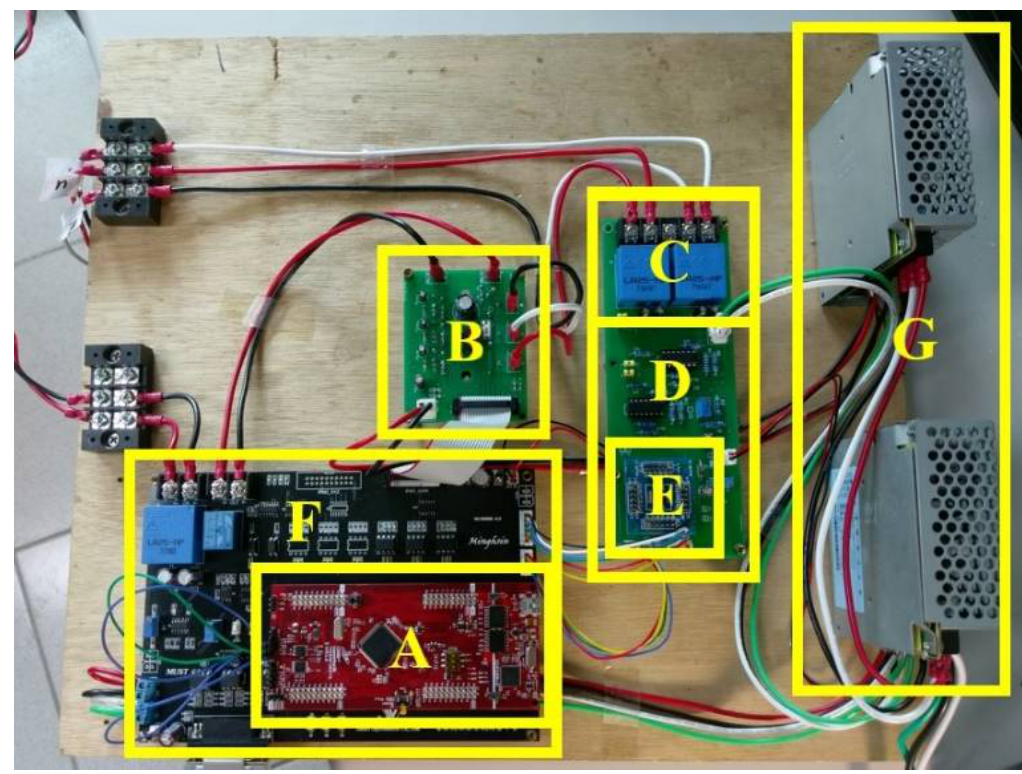
Figure 6. Hardware circuits of the SynRM drive system.